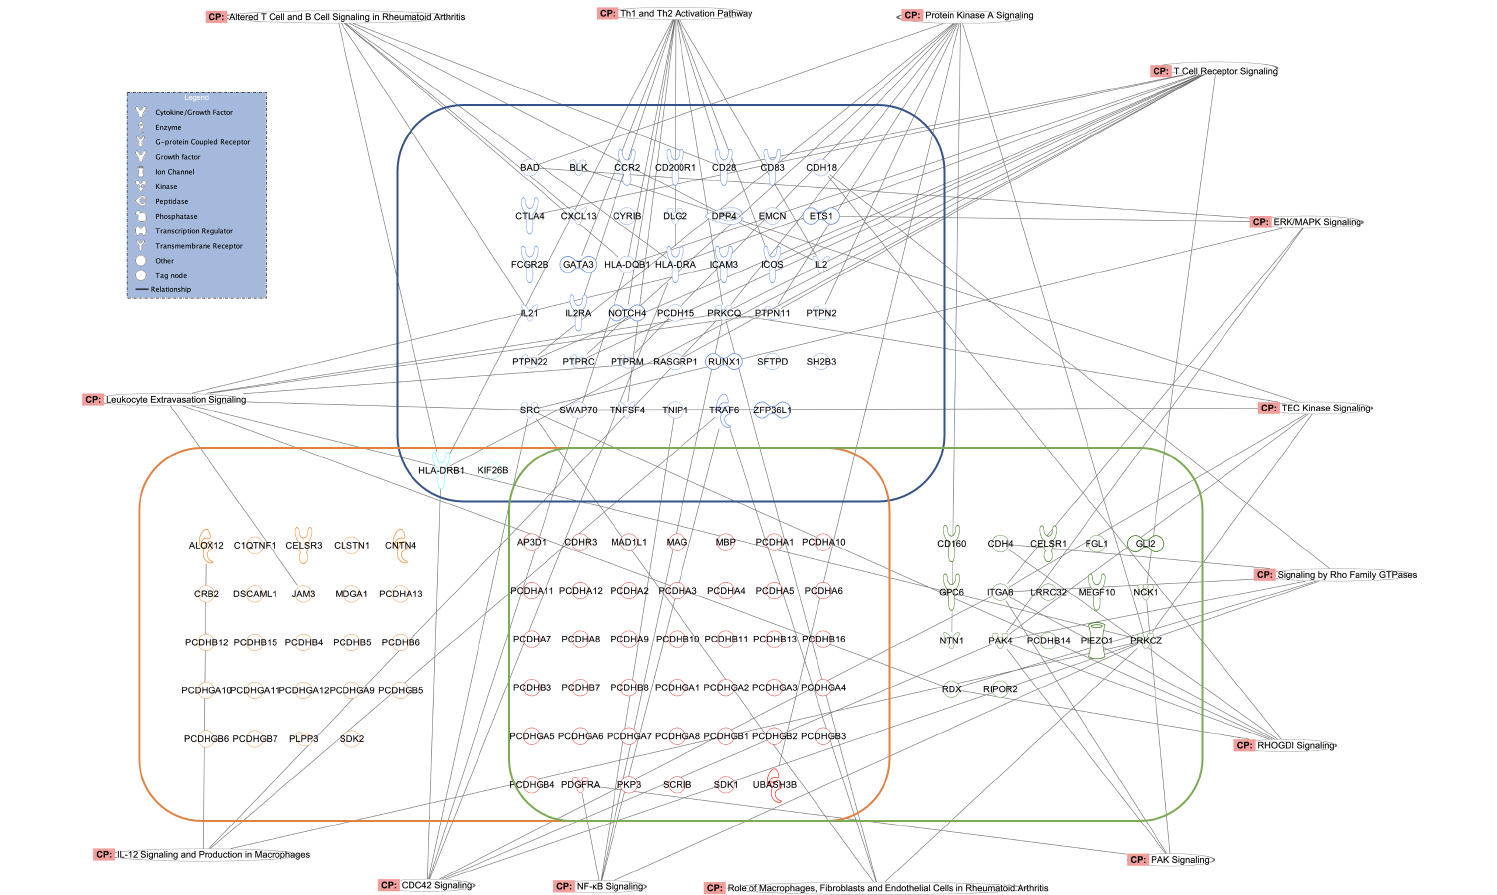
Figure 8. Overlaid IPA canonical pathways for the gene sets involved in the biological process of cell–cell adhesion (GO:0098609). Genes for RA GWAS SNPs, ACPA-associated DMRs and RA-associated DMRs are surrounded by the blue, orange and green boxes, respectively. The genes shared across sets are placed in the intersection areas. The genes in highlighted canonical pathways are connected to the pathway names by